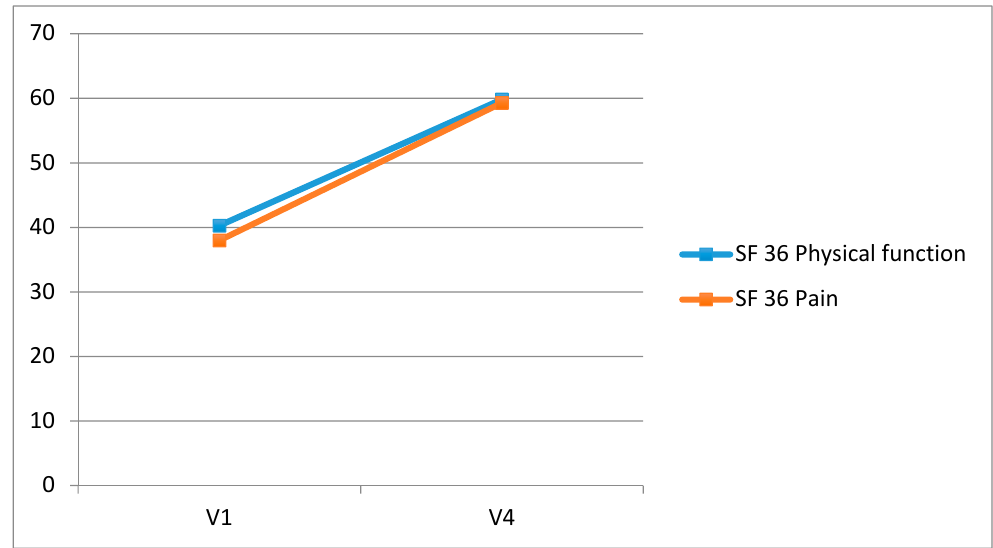
Figure 3. Statistically significant difference between baseline and 30 and 60 days follow-up of the Wilcoxon test. CoGA, Clinical Observer Global Assessment, PtGA, Patient’s Global Assessment.